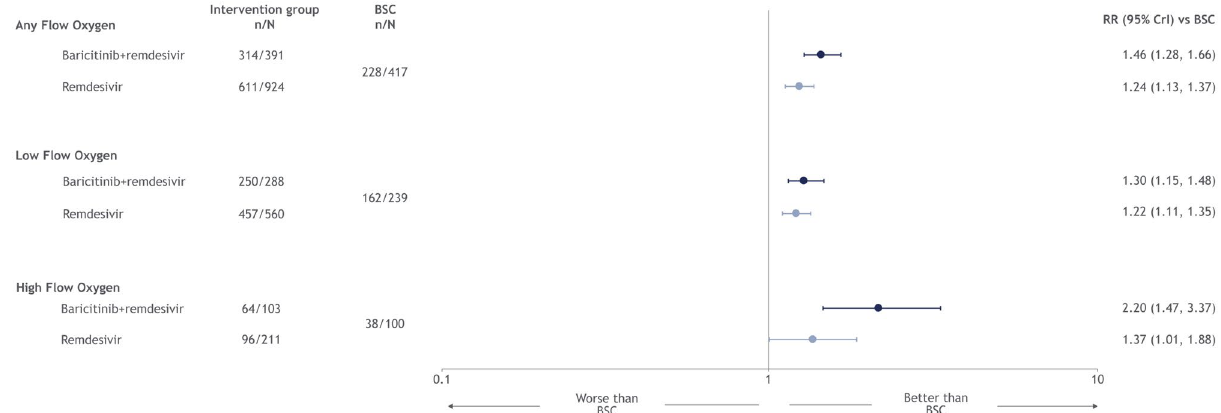
Figure 4. Forest plot for free from oxygen support endpoint, by type of non-invasive oxygen support.